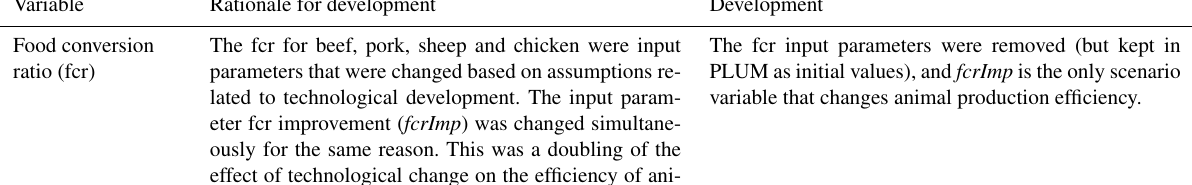
Table A1. PLUM development, affected variable, rationale for development and implemented development. Variable Rationale for